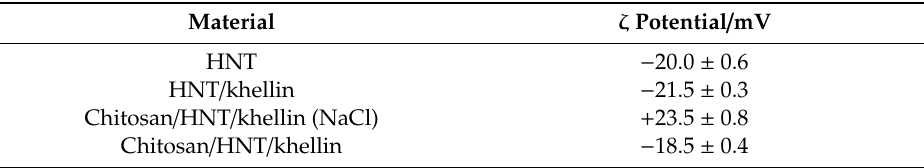
Table 1. ζ potential for halloysite nanotubes (HNT), HNT / khellin and chitosan / HNT / khellin composite materials.